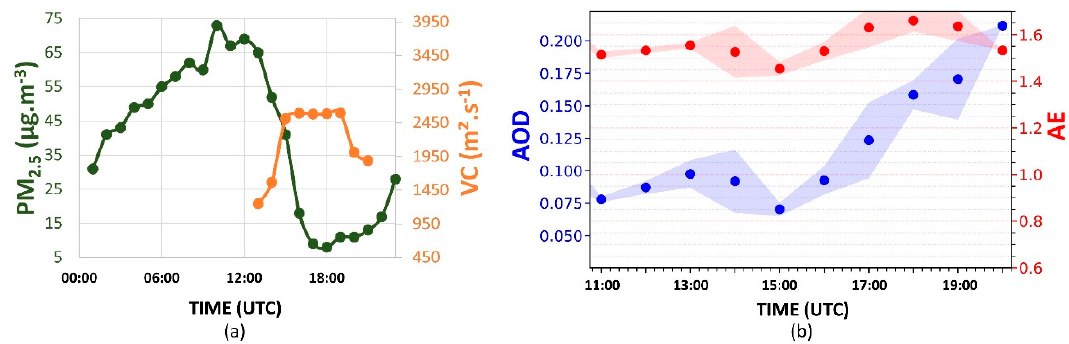
Figure 16. ( a ) Daily cycles of PM 2.5 concentration (green dots) and VC (orange dots); ( b ) AOD at 500 nm (blue points) and AE (440/675) (red points) hourly averages variation from 11:00 UTC to 20:00 UTC, on 24 July 2019. The blue and red shadows represent the AOD and AE standard deviation, respectively. The AERONET data level is 1.5 for AOD and AE.